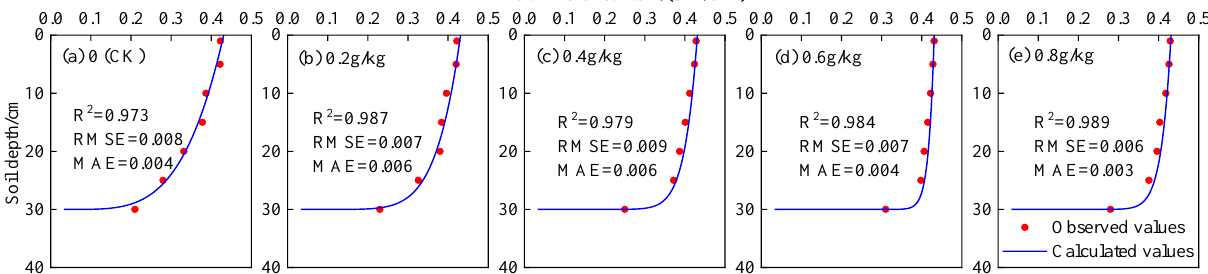
Figure 4. Comparison of the calculated and observed soil water content. ( a ) 0 (CK); ( b ) 0.2 g/kg; ( c ) 0.4 g/kg; ( d ) 0.6 g/kg; ( e ) 0.8 g/kg.